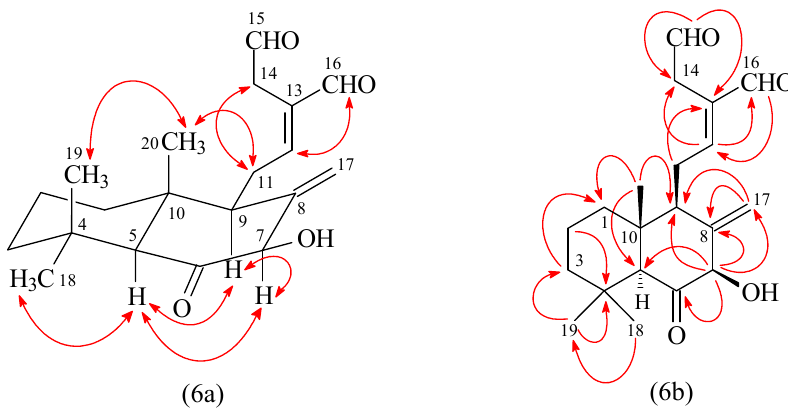
Figure 6. Key NOESY (6a) and HMBC (6b) correlations of 4